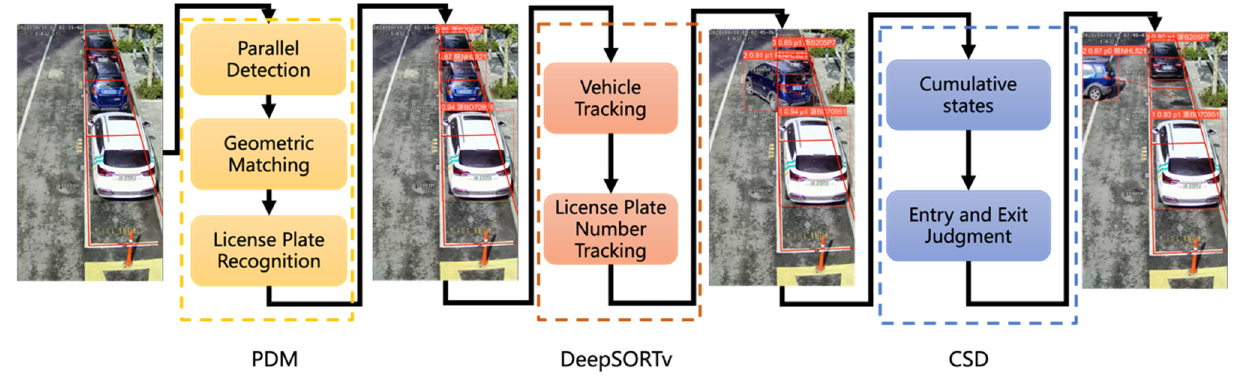
Figure 2. The overall framework of the proposed algorithm.